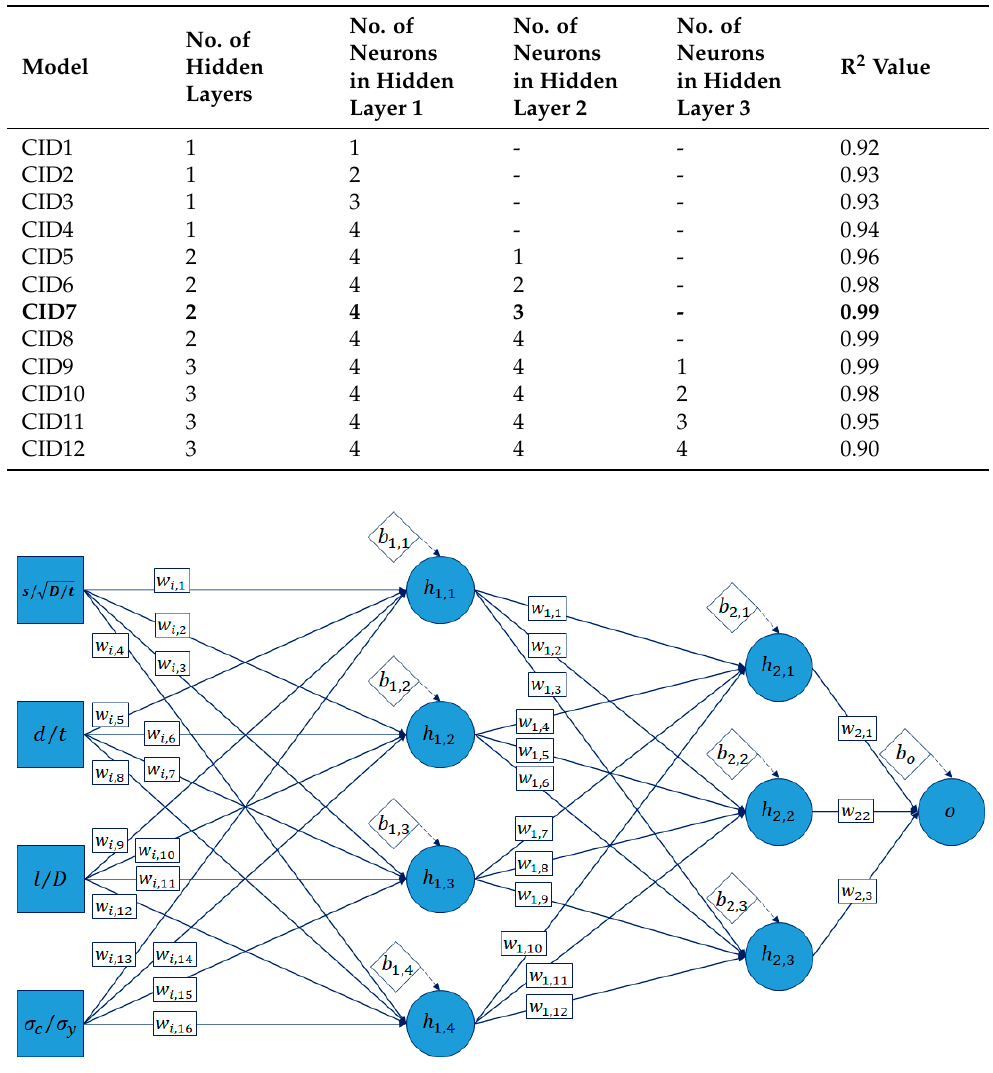
Figure 6. Architecture of the model CID7. The ANN was developed to produce an output based on four input variables. The input variables are normalised defect spacing, depth and length, and normalised longitudi- nal compressive stress. The output of the ANN model is the normalised failure pressure of the pipe. The performance of the ANN model was evaluated using a regression plot, as shown in Figure 7. Based on Figure 7, the capability of the model to produce results similar to that of the training data is indicated by the overlapping solid and dashed lines in the